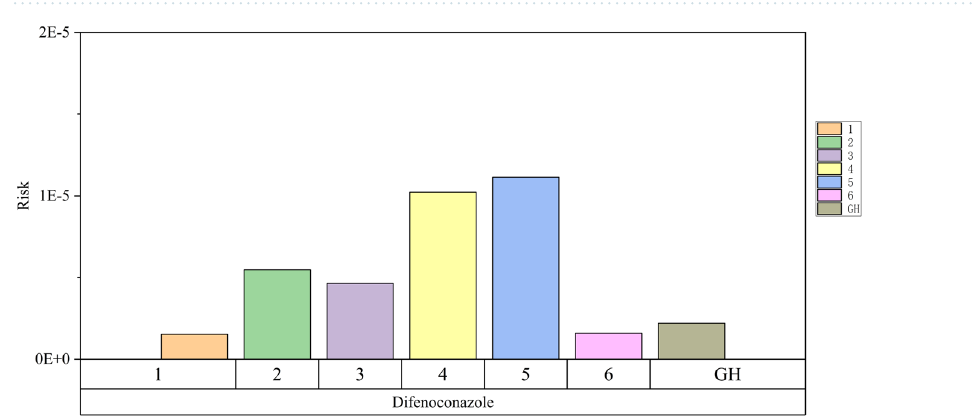
Figure 4. Cancer exposure risk of acetochlor and